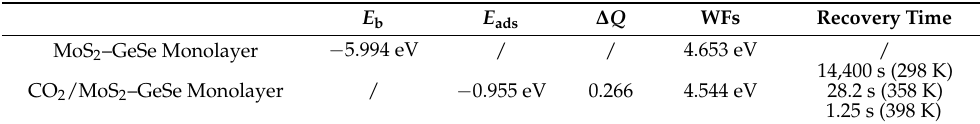
Table 2. Main Table 2. Main parameters.